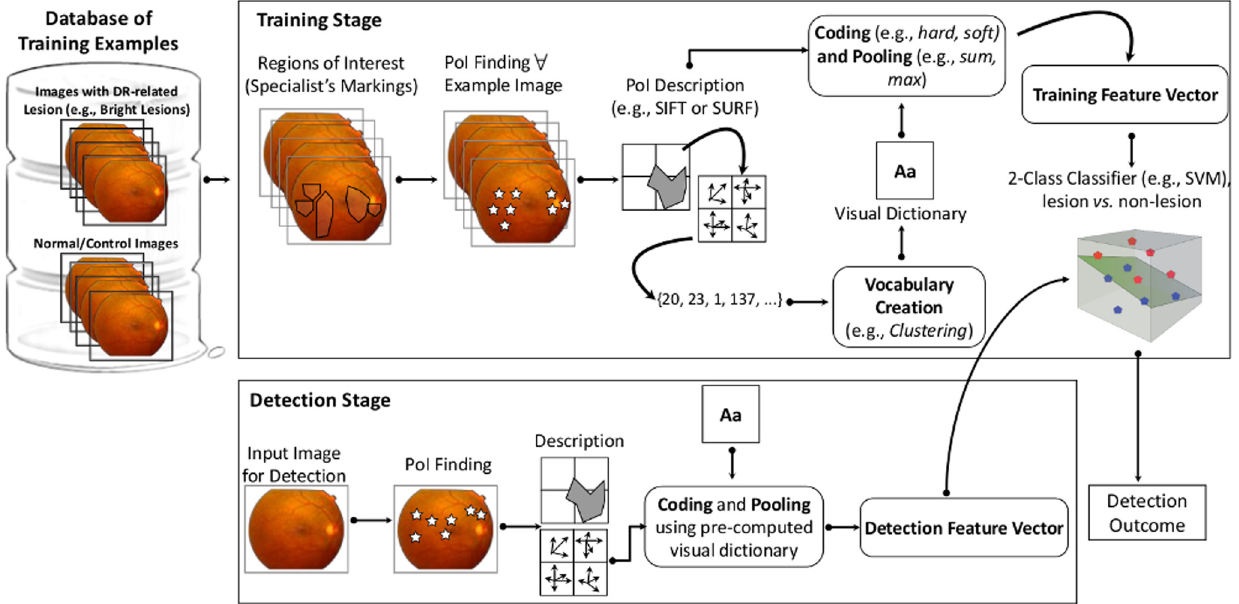
Fig 2. Pipeline of the BoVW-based automated diabetic retinopathy classification system for abnormal retinal images identification. For Low-Level feature extraction, the proposed method identifies Points of Interest (points in high-contrast or context-changing areas) within regions of interest which contain specific lesions marked and reviewed by specialists during the training of the method. For Codebook Learning (vocabulary creation), the method uses the k-means clustering method with Euclidean distance over a sample of the points of interest. The centroids are used as representatives codewords (the most important points of interests, for instance). With the codebook and the low-level description of a set of training images for a specific DR-related lesion, the Mid-Level feature extraction step employs the classical coding/pooling combination (hard/sum), that consists of defining a histogram that reveals the number of activations for each visual word in each analyzed image. For the Decision model training, the current method requires the training of one decision model for normal vs. bright lesions, normal vs. red lesions, or normal vs. multi-lesion